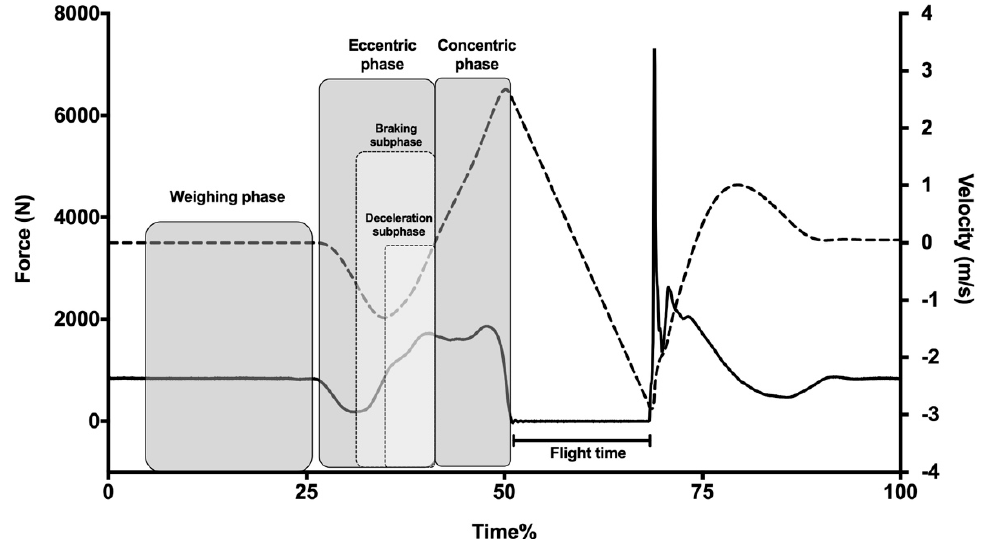
Figure 1. Force- and velocity-time curves of a representative participant.